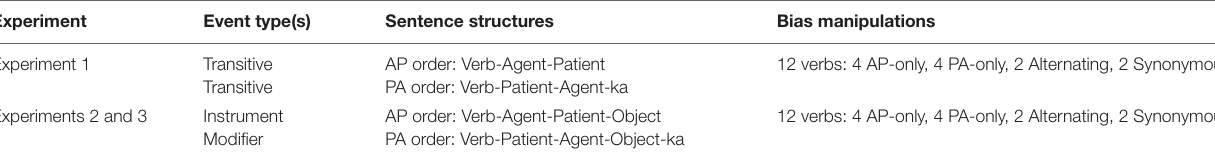
TABLE 1 | Miniature language input provided to participants in the three